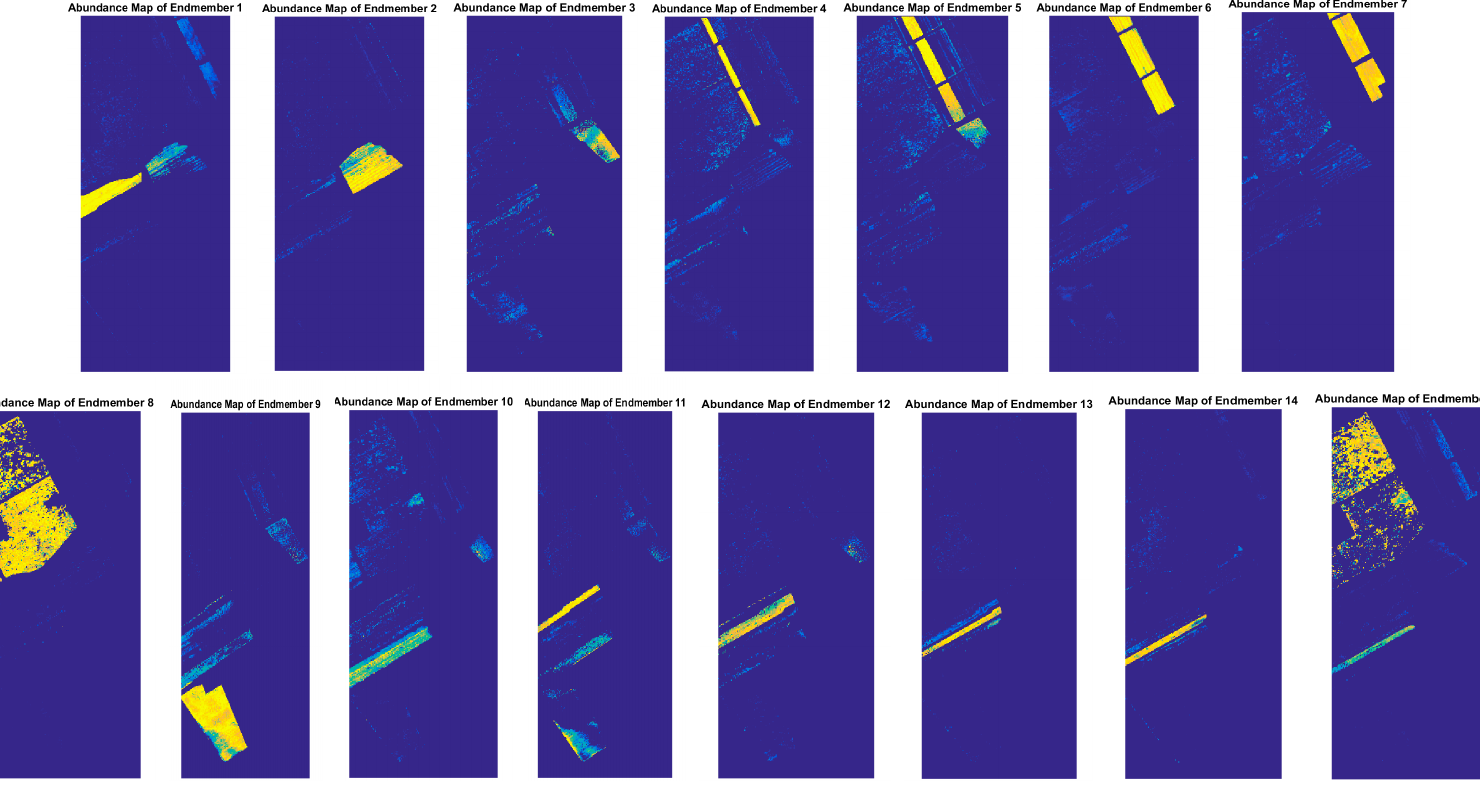
Figure 19. The fractional abundances estimated from the Salinas area using the fully constrained least squares (FCLS) method and the selected bands by the proposed ISI-PS algorithm in the supervised approach.